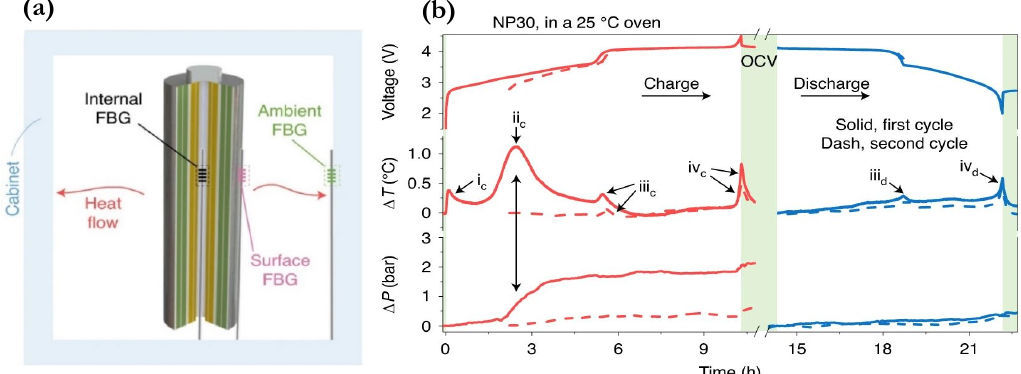
Figure 8. Pressure and internal temperature probing based on FBGs [120]: ( a ) schematic of integrating FBG sensors into the central void of cylindrical jelly-roll Li-ion batteries; ( b ) tracking of solid electrolyte interface (SEI) formation through pressure dynamics data and identification of thermal events (labeled peaks) at C/10 charge/discharge rate, demodulated from Bragg wavelength shifts. (Reproduced with permission from Huang et al. Nature Energy; published by Springer Nature,